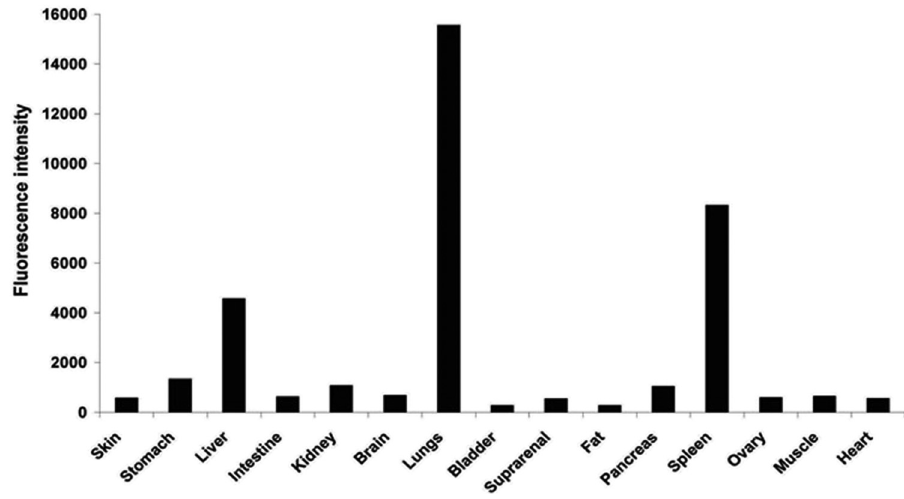
Figure 6: Biodistribution of CIS/ZnS QDs in major organs of a mouse after 24 h of administration; with permission from ref. [ 117 ] ;